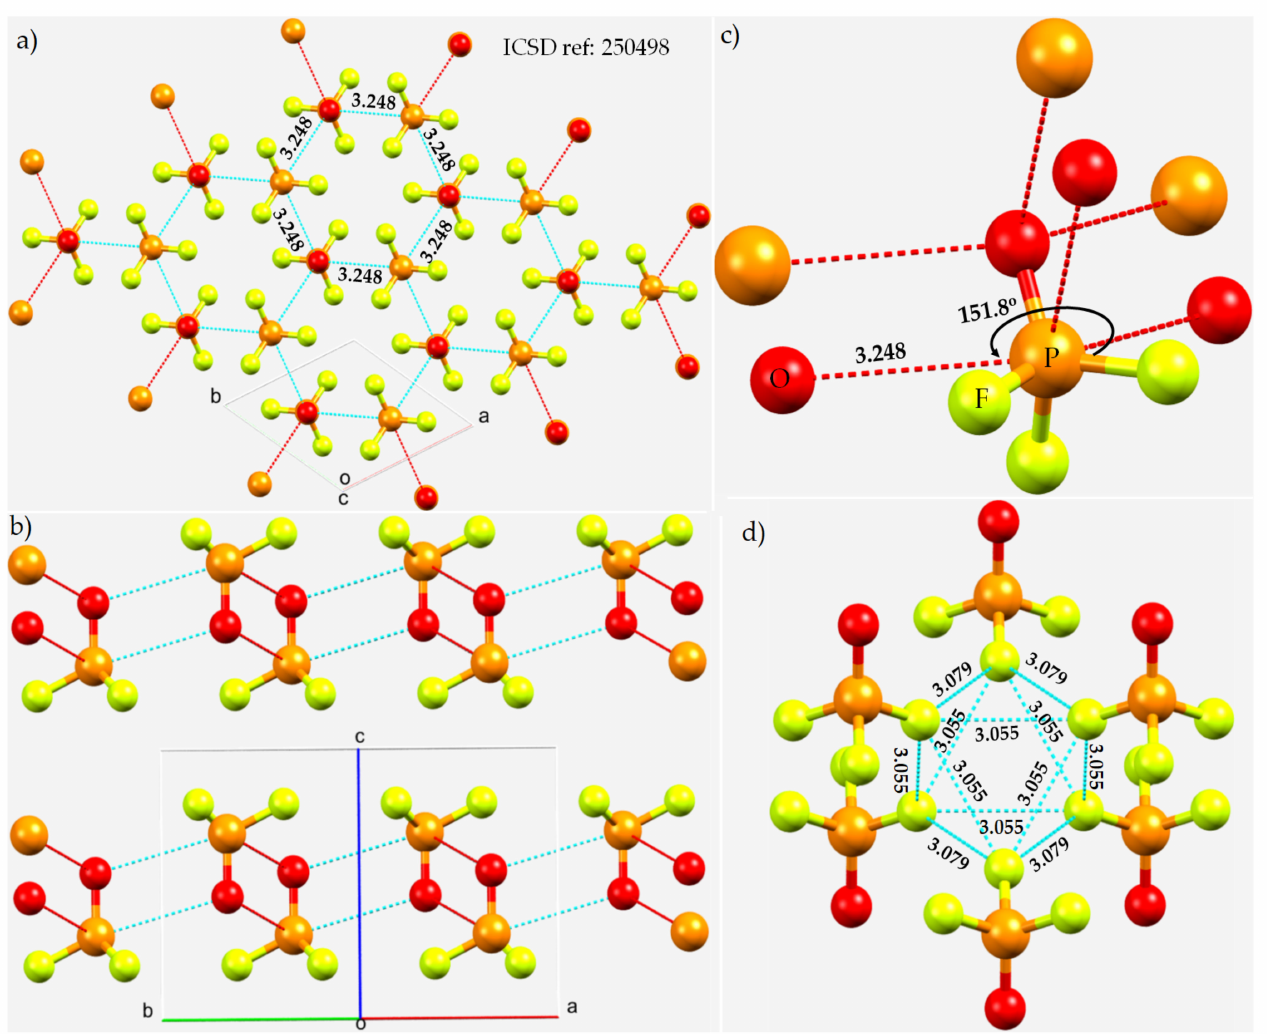
Figure 10. ( a , b ) Illustration of two different views of phosphorus bonding in the 3 × 3 × 3 and 2 × 2 × 2 supercell structures of the crystal of POF 3 (space group: P 3 m1 ), with the former showing a hexagonal pattern of bonding within a given layer and the latter showing a layer-like structure. ( c ) The local pattern of P ··· O bonding around each POF 3 molecular entity in the crystal. ( d ) The local pattern of F ··· F bonding between the POF 3 molecules in the crystal. Atom type is shown in ( c ), and selected bond distances and bond angles are given in Å and degrees,